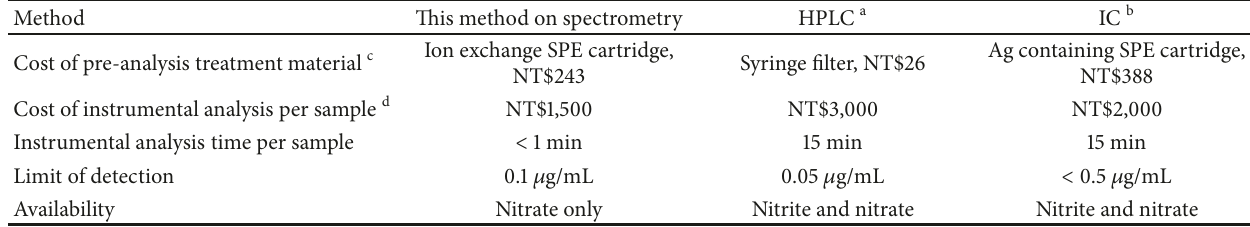
Table 4: Comparisons among analyses on spectrometry, HPLC and